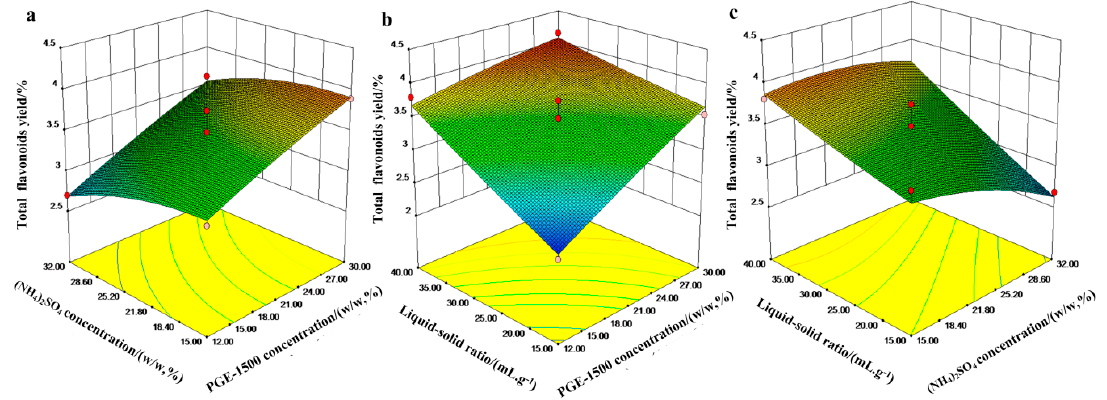
Figure 4. Interactive effects of any two factors on the yield of total flavonoids. ( a ) PEG1500 concentration ( X 1 ) and (NH 4 ) 2 SO 4 concentration ( X 2 ), ( b ) PEG1500 concentration ( X 1 ) and aqueous two-phase system (ATPS) solvent volume/leaf mass ratio ( X 3 ), and ( c ) (NH 4 ) 2 SO 4 ( X 2 ) and ATPS solvent volume/leaf mass ratio ( X 3 ).